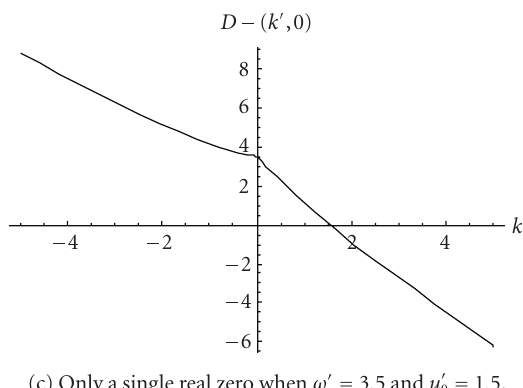
Figure 4.1. Illustrative graphs of D − ( k ,0) for the three cases of possible real